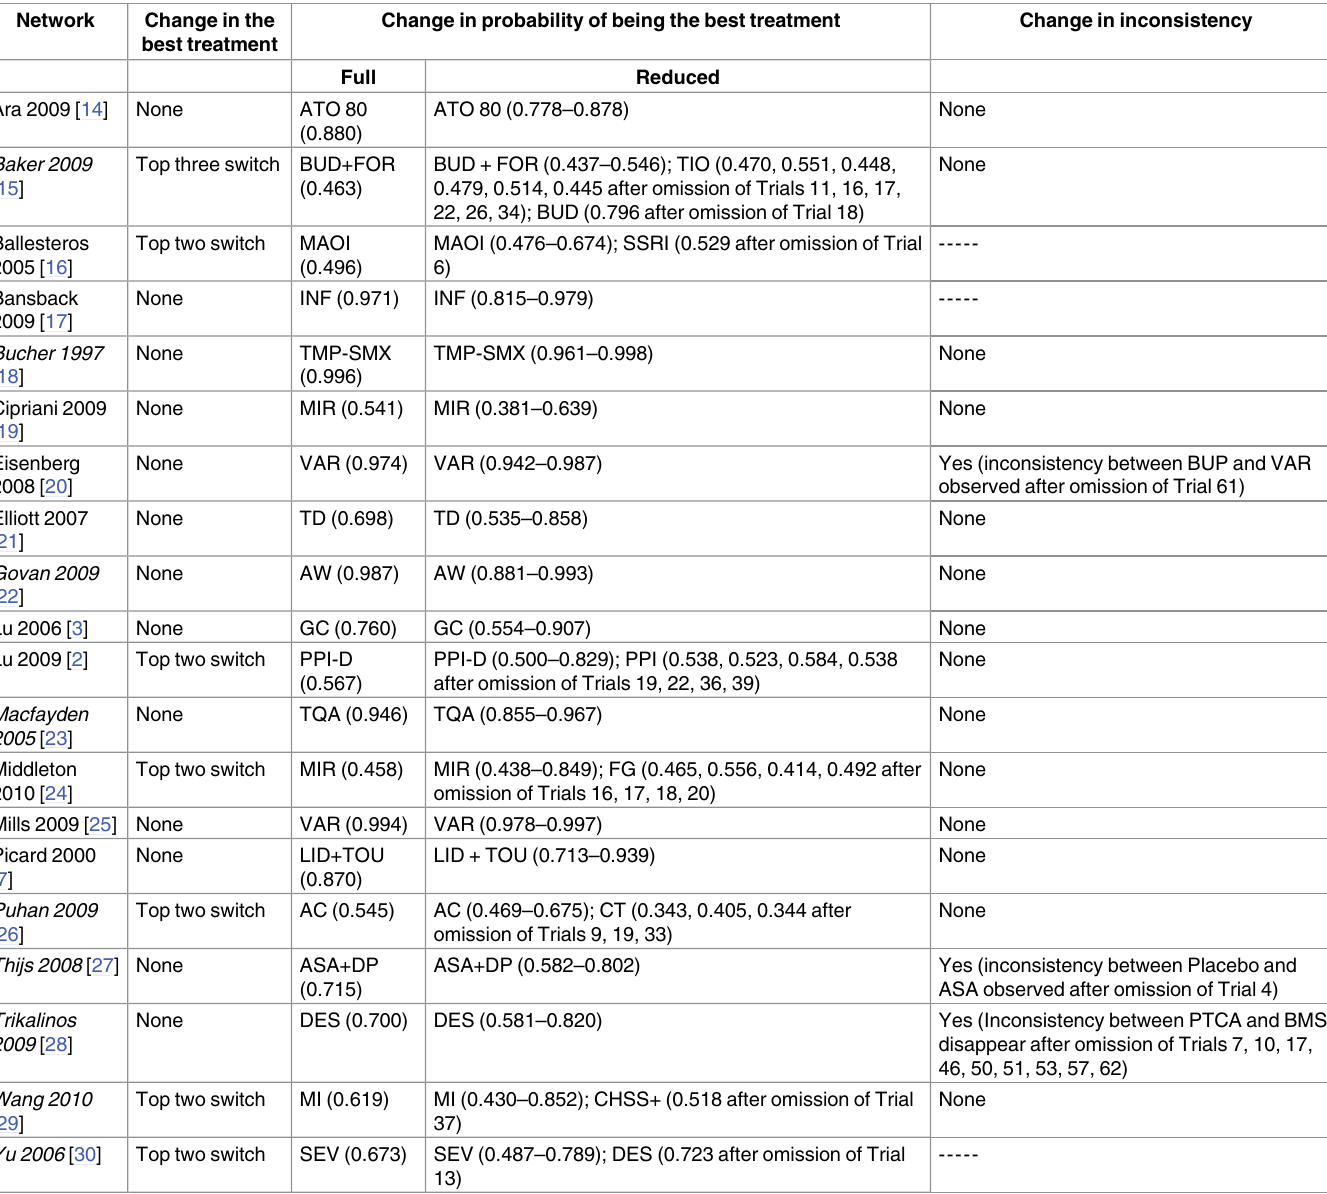
Table 3. Impact on treatment ranks, probability of the best treatment, and inconsistency using the AB approach. Note: For networks in italics, the treatment with the lowest event rate is the best treatment; for the other networks, the treatment with the highestevent rate is the best treatment. -----repre- sents that inconsistency cannot be